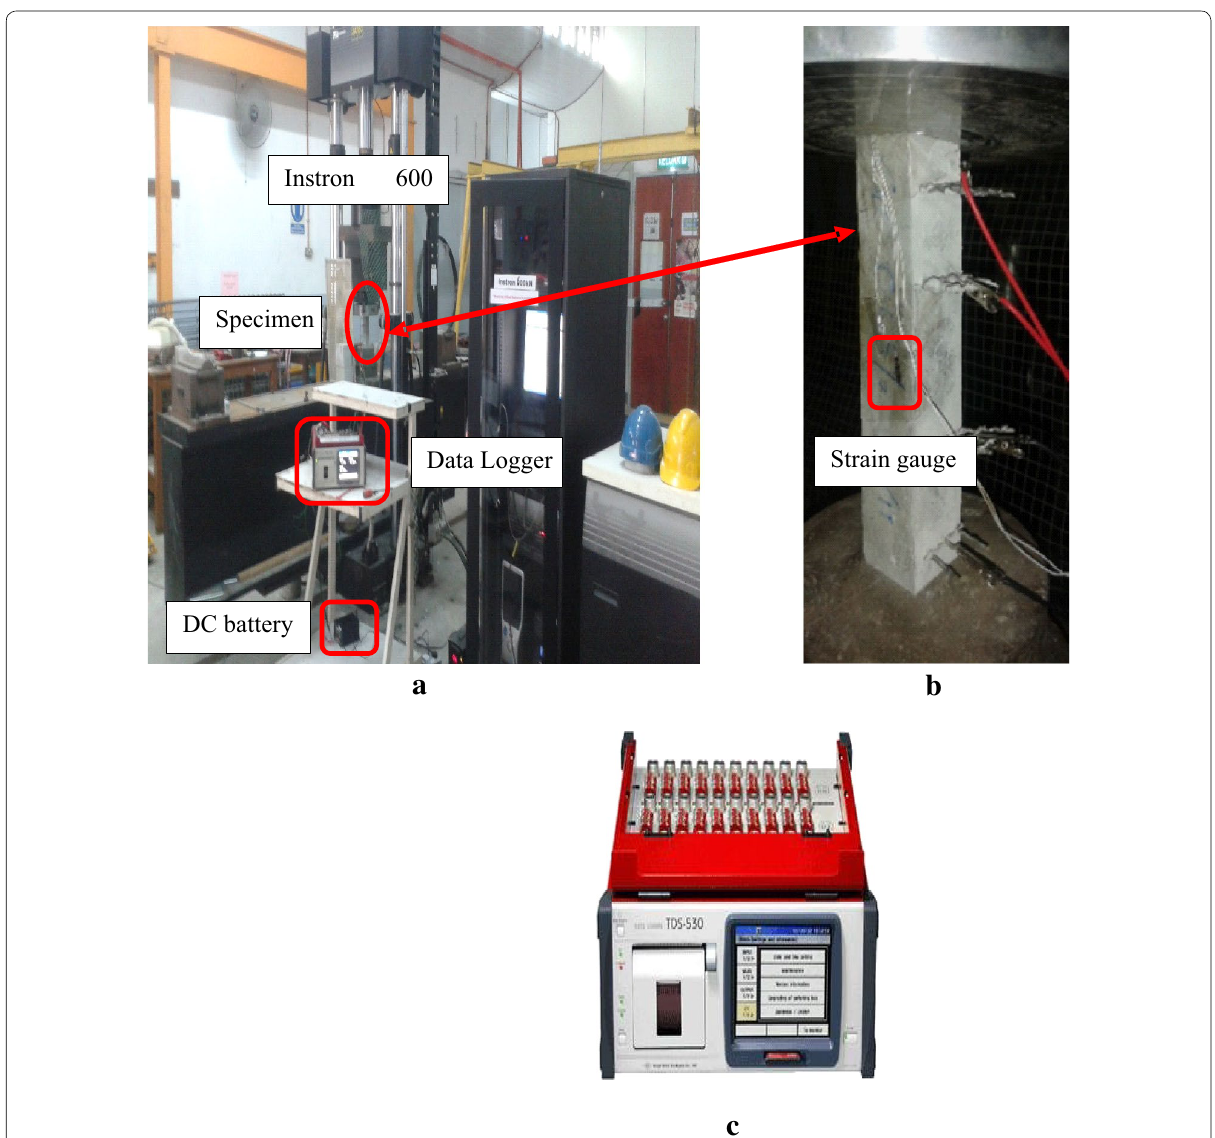
Fig. 3 Measurements of piezoresistive properties; a Setup for electrical properties; b specimen placement; and c TDS-530